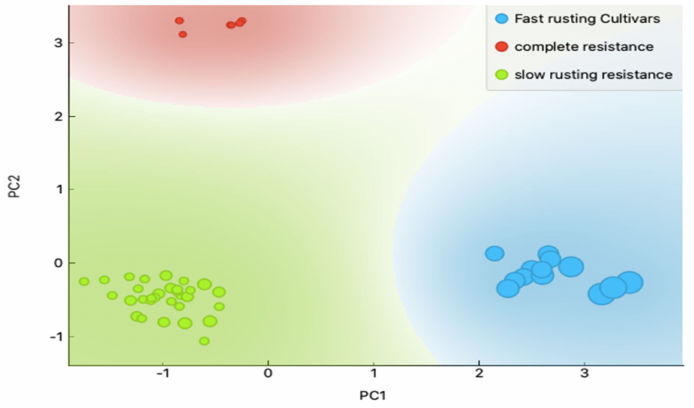
Figure 2. Principal component analysis (PCA) based on the Lr genes’ scoring data. The figure demon- strates a sharp clustering into three distinctive groups (green: slow rusting resistance genotypes; red: complete resistance genotypes; blue: slow rusting resistance